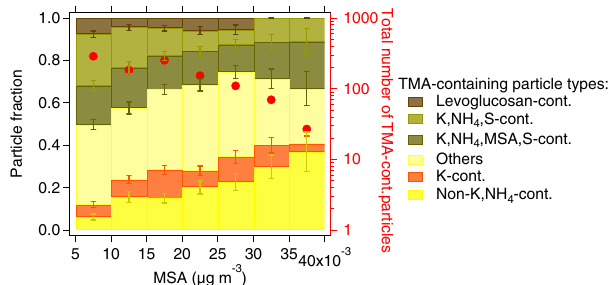
Figure 14. MSA concentrations measured with the HR-ToF- AMS compared with the cumulative fraction of TMA-containing particle sub-types (normalized to all TMA-containing particles (indicated by red dots)): “K,NH 4 ,MSA,S-containing” (dark green), “K,NH 4 ,S-containing” (light green), “K-containing” (orange), “Non-K,NH 4 -containing” (yellow), “levoglucosan-containing” (brown) and “others” (light